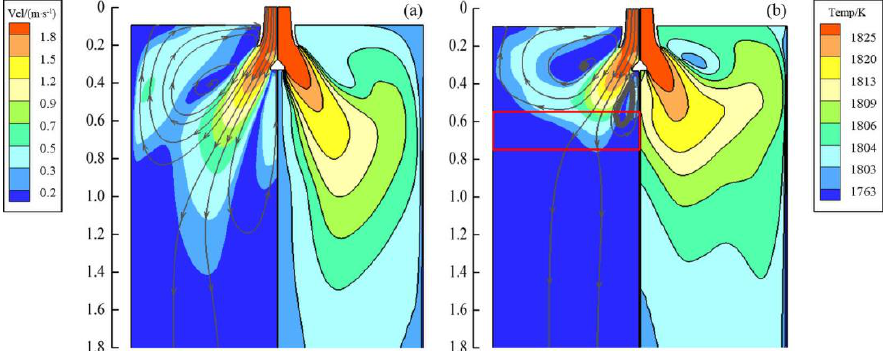
Figure 13. Velocity (left half of each subfigure) and temperature (right half of each subfigure) distribution of molten steel in the central plane of the CSP mold thickness: ( a ) B max = 0 T and ( b ) B max = 0.5 T.